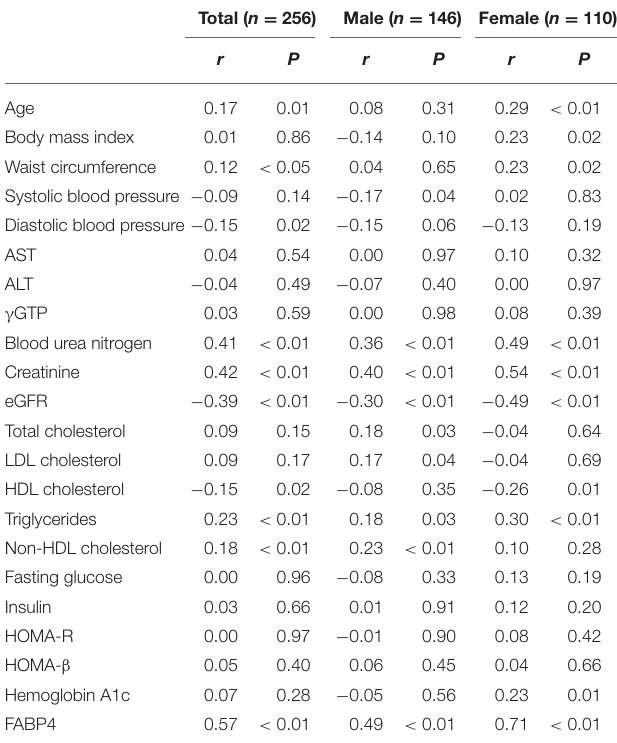
TABLE 3 | Multivariable regression analysis for FABP4. TABLE 4 | Correlation analysis for FABP5.